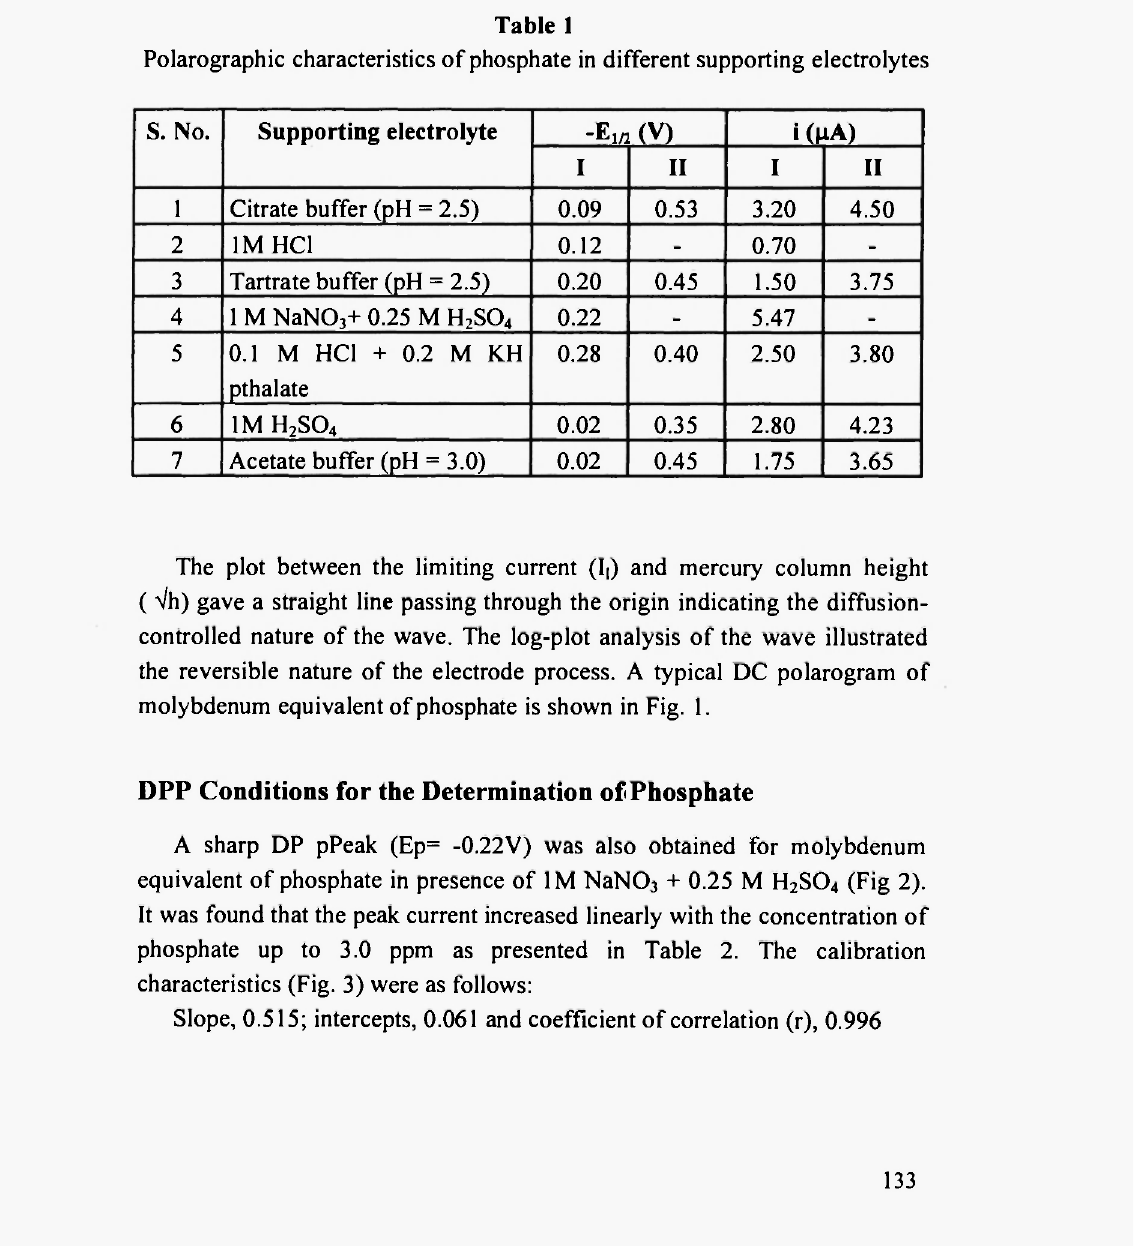
Polarographic characteristics of phosphate in different supporting electrolytes S. No. Supporting electrolyte -Ε